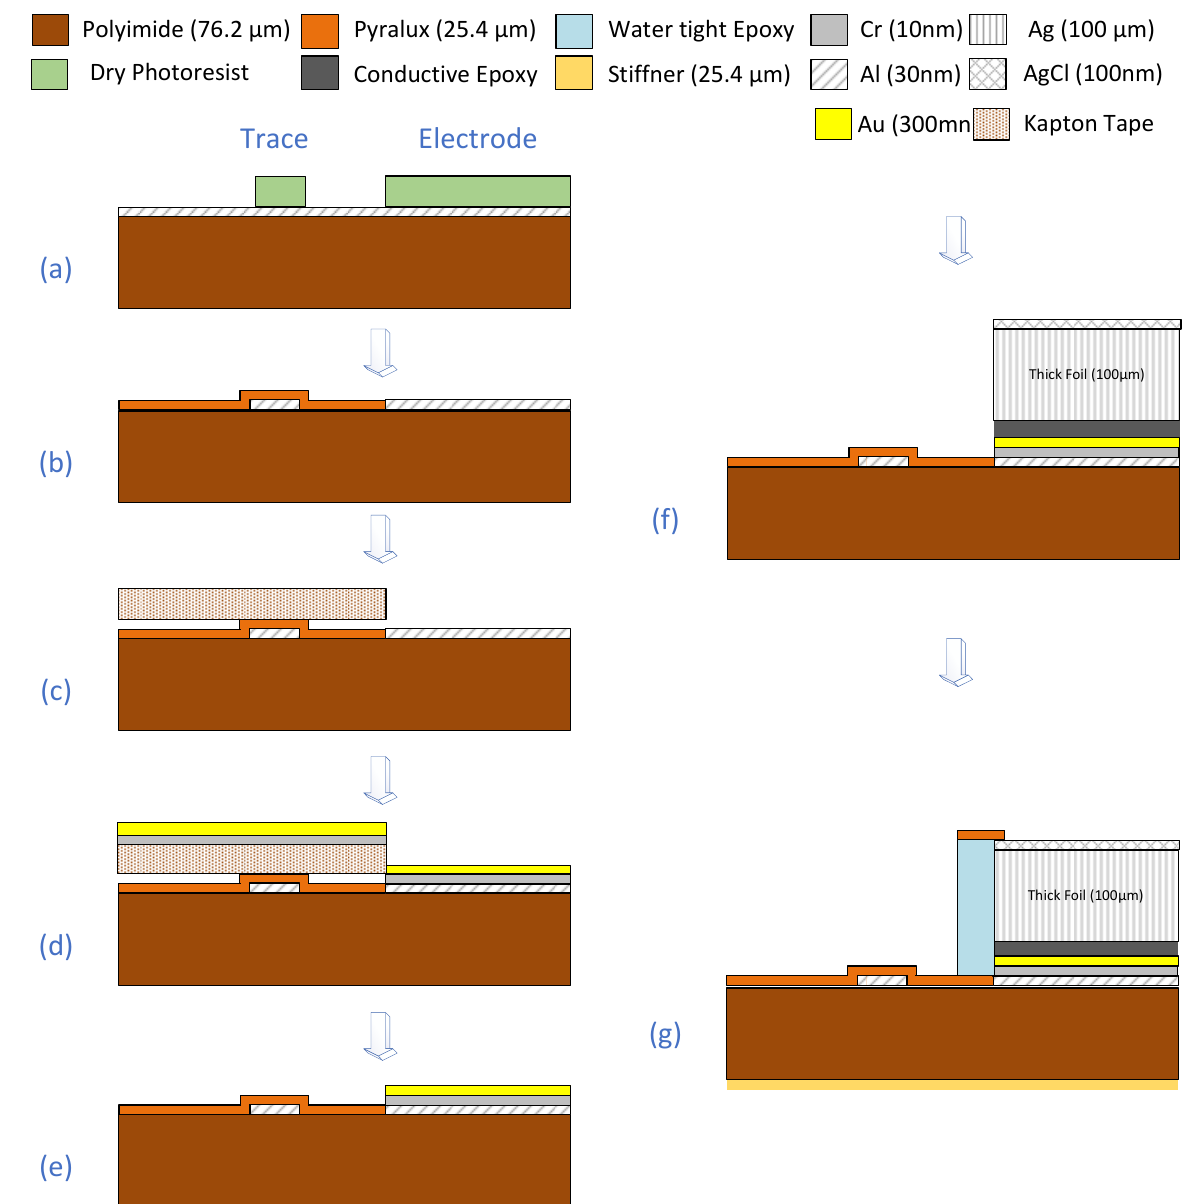
Figure 2. The fabrication process flowchart for the NeoNet traces and electrodes . ( I ) Photolithography of the Al metalized polyimide. ( II ) Trace insulation. ( III ) Masking. ( IV ) E-beam deposition. ( V ) Wet etching. ( VI ) Electrode assembly. ( VII ) Electrode waterproofing.